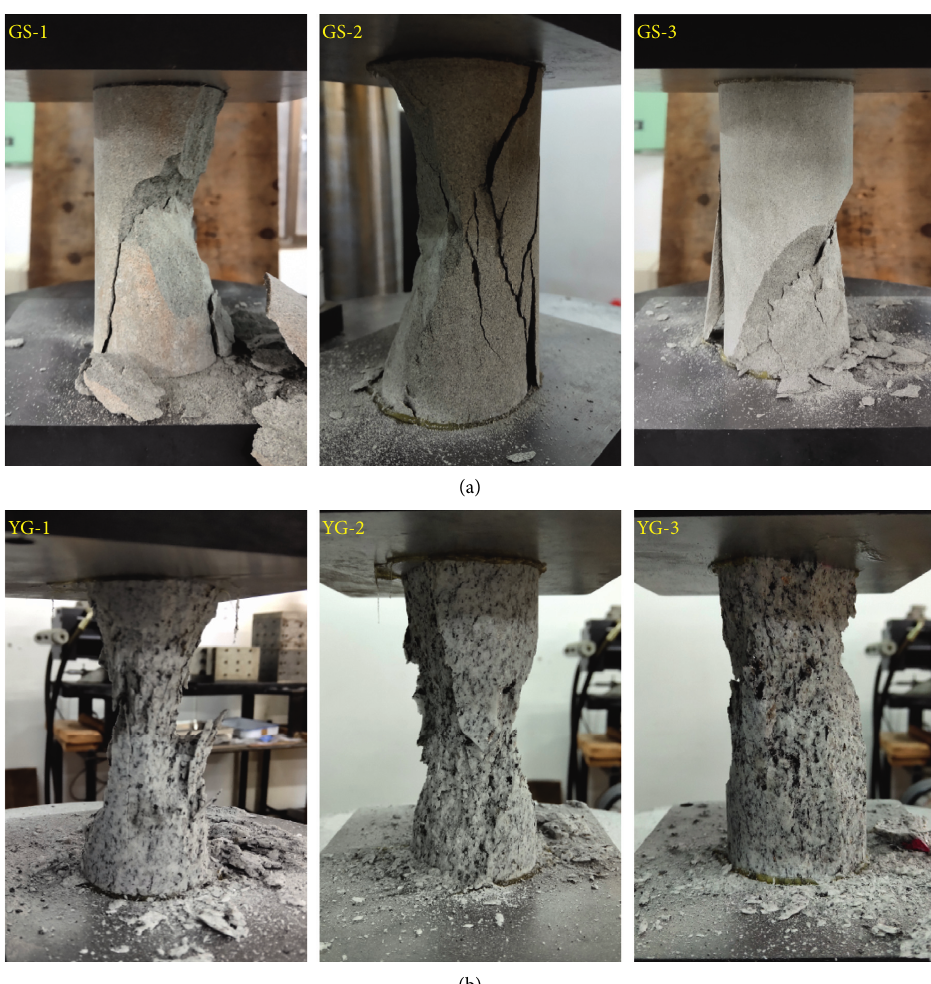
Figure 11: Failure modes of rock specimens in cyclic loading-unloading test: (a) Green sandstone; (b) Yueyang